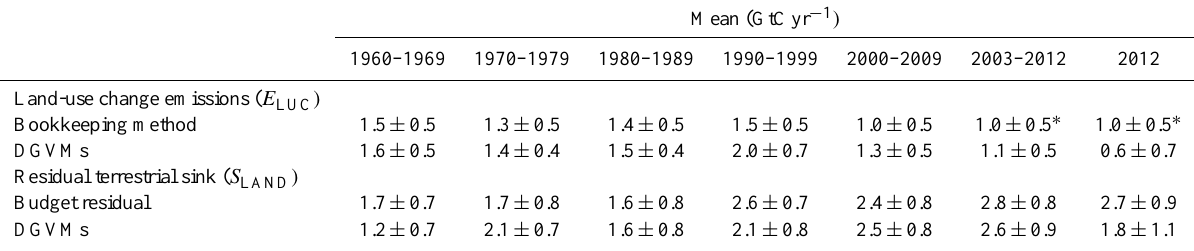
Table 7. Comparison of results from the bookkeeping model and budget residuals with results from the DGVMs for the periods 1960–1969, sents ± 1 σ of results from the nine individual